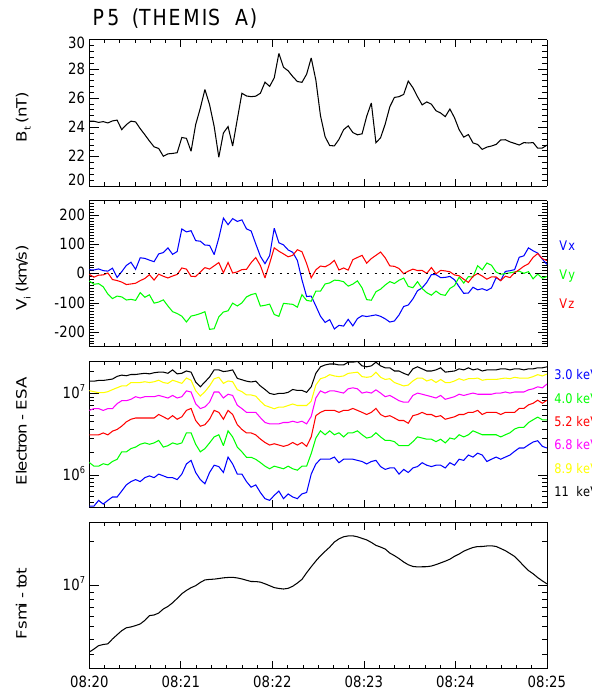
Fig. 8. The observations of the magnetic field strength B t , the plasma flow V i , and electron injection data (3–11KeV) recorded by P5 and the integrated brightness (image totals) of all-sky images at Fort Smith (the Alfv´en transit time between the magnetotail and the ionosphere is taken into account) during the plasma flow vortex